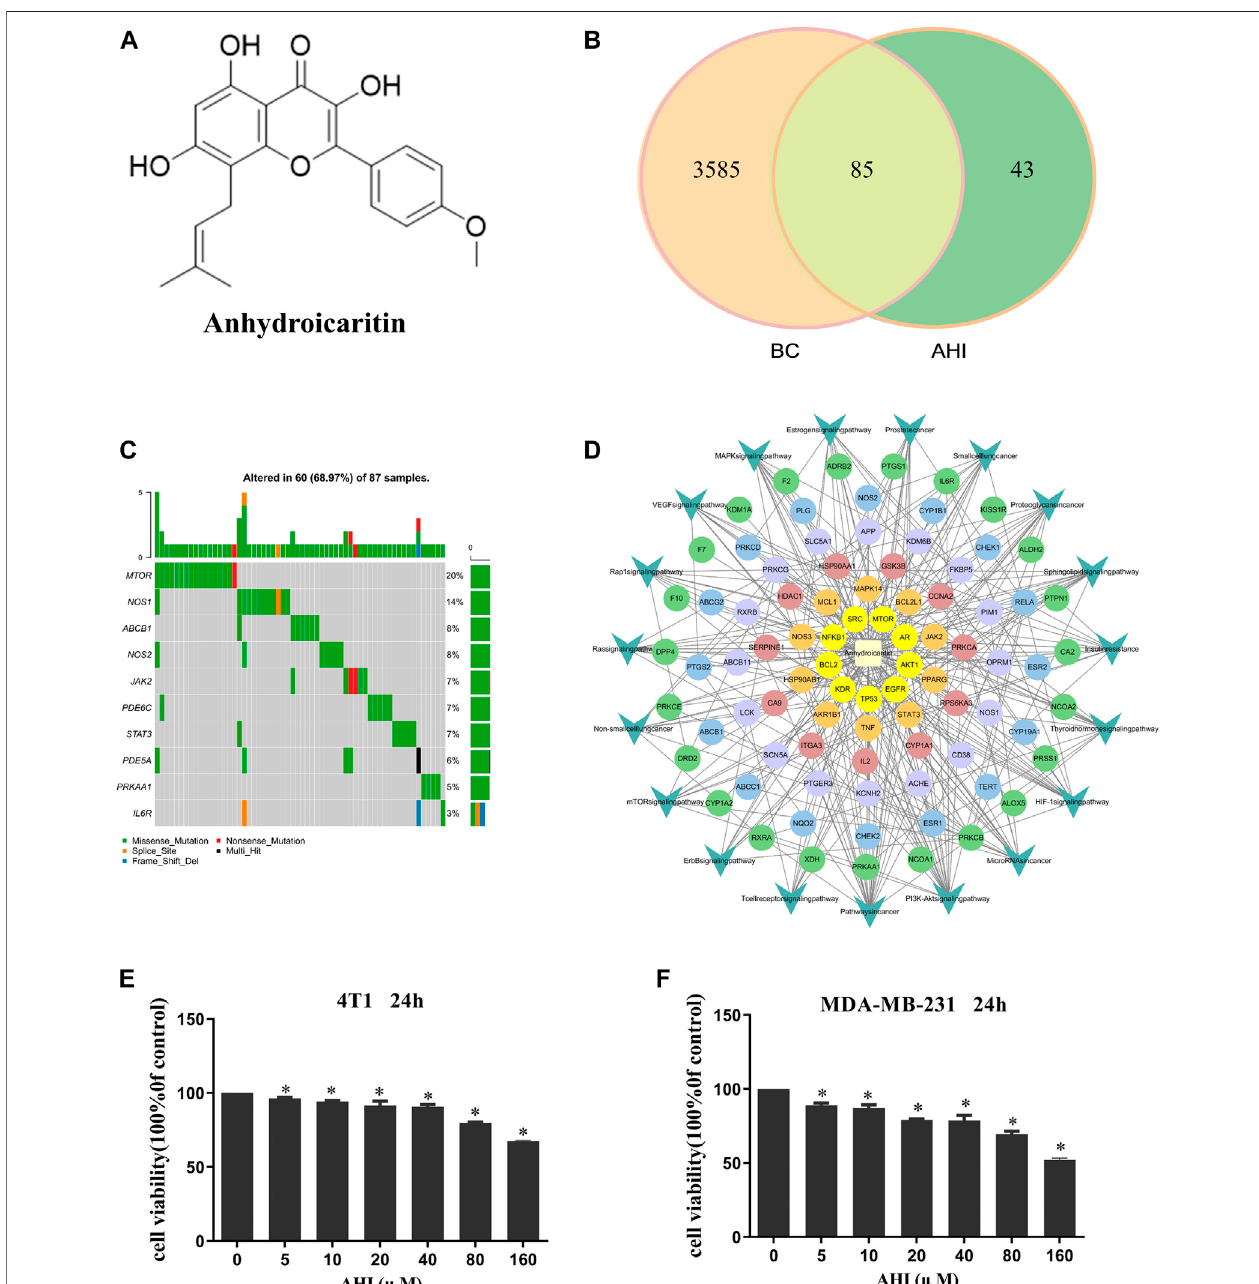
FIGURE 2 | AHI treatment potential in BC. (A) Chemical structure of AHI. (B) Venn diagram depicting the number of potential targets of AHI for BC treatment. (C) Waterfallmapofthemutationinformation(TCGA-downloadedBCdata). (D) AHI – targets – pathwaysnetwork.(Thecirclerepresentsthetargets,andthearrowrepresents the pathways.) (E , F) AHI inhibited the survival of the 4T1 and MDA-MB-231 cells at different concentrations (24 h). * p < 0.05.